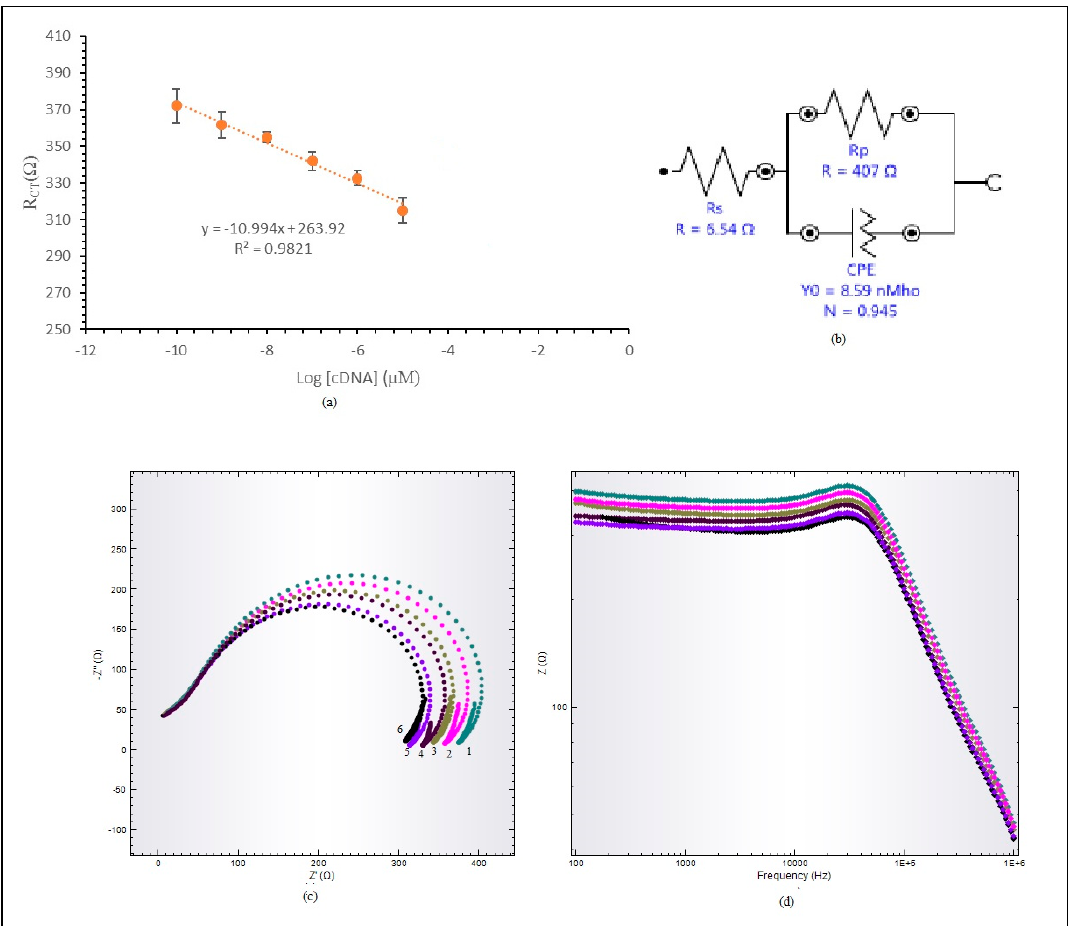
Figure 6. ( a ) Linear response range for label-free E. coli DNA biosensor. ( b ) Fitted equivalent circuit representing label-free E. coli DNA. ( c ) Nyquist plot. ( d ) Bode plot modulus for label-free E. coli DNA biosensor linear range.